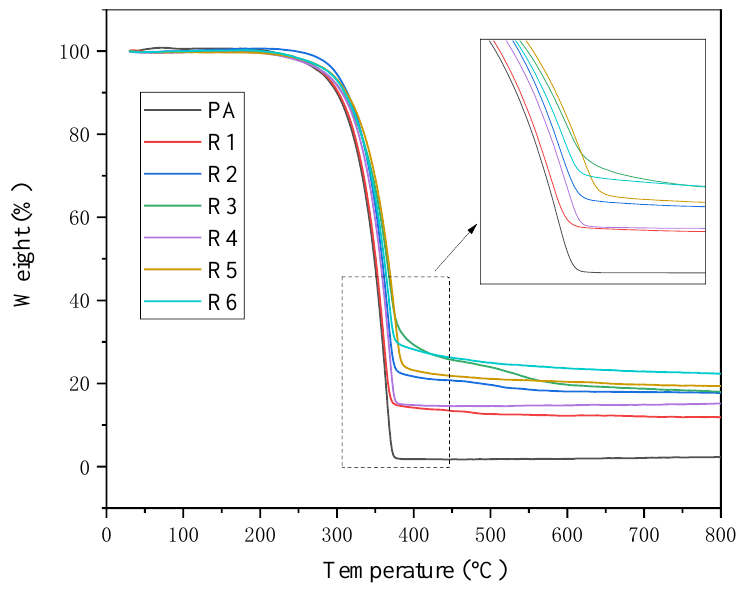
Figure 7. TG curve. Table 3. Specific thermogravimetric parameters of PCMs.